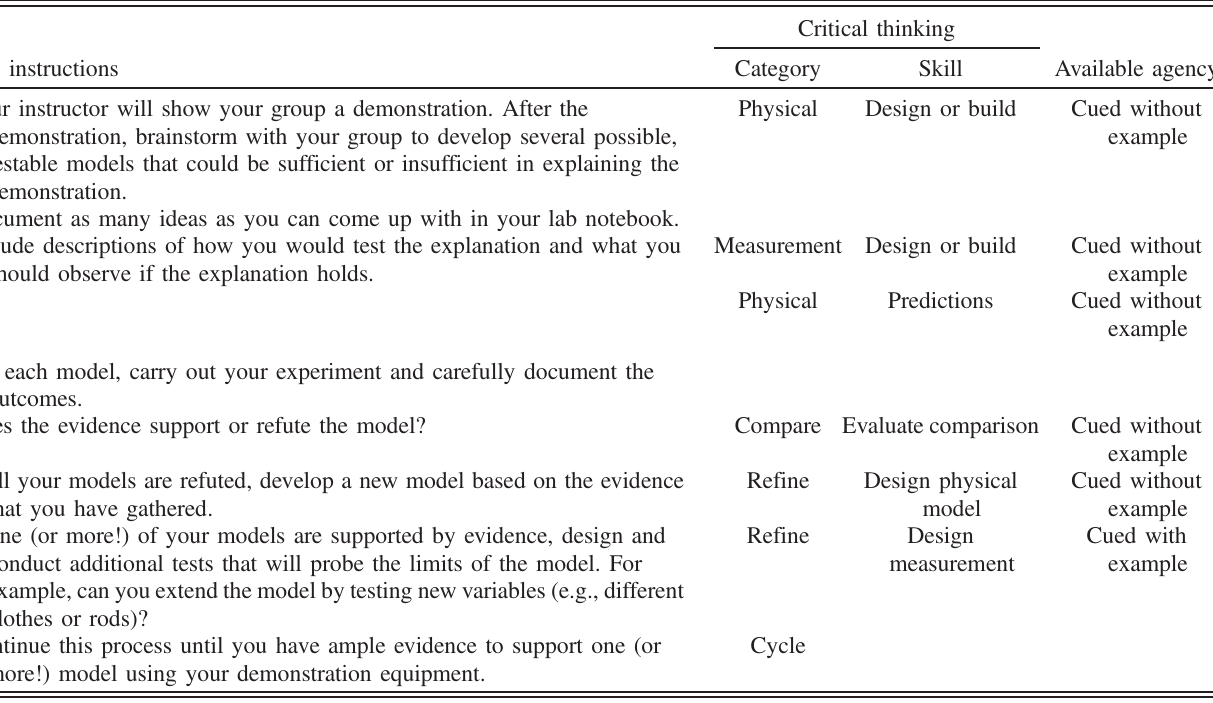
TABLE II. Application of coding scheme for an excerpt from the Electrostatics activity in semester